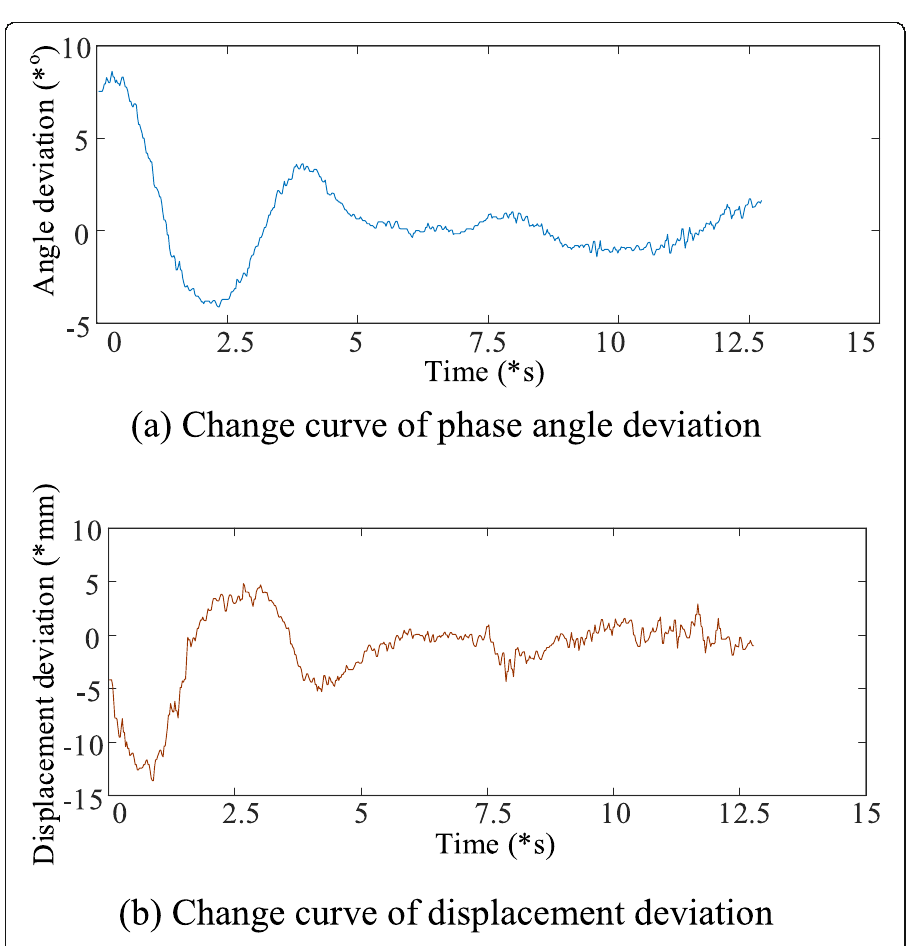
Fig. 10 Motion curve of typical scene 3. a Change curve of phase angle deviation. b Change curve of displacement